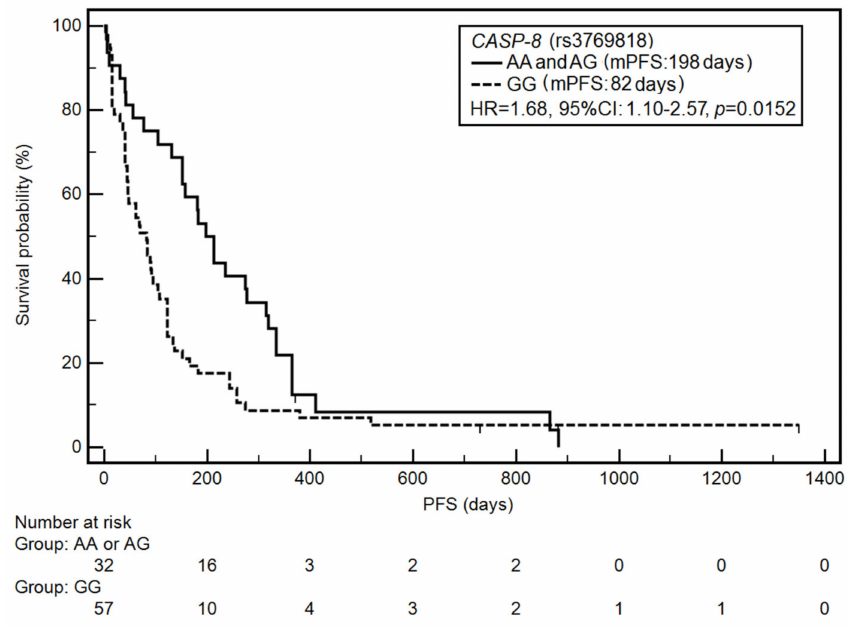
Figure 1. Kaplan–Meier curves illustrating progression-free survival (PFS) differences between genotypes AA and AG, GG of the CASP-8 gene (rs3769818). In contrast, the higher risk of TTP shortening was associated with a higher stage of disease (HR = 2.56, 95% CI: 1.67–3.92, p < 0.0001), a longer smoking period (HR = 1.54, 95% CI: 1.00–2.36, p = 0.0408), the use of cisplatin and pemetrexed in first-line chemotherapy (HR = 1.72, 95% CI: 0.97–3.03, p = 0.0240), a lower number of cycles (HR = 3.80, 95% CI: 1.90–7.59, p < 0.0001), the presence of distant metastases (HR = 2.36, 95% CI: 1.46–3.82, p = 0.0013), the GG genotype of the CASP-8 gene (HR = 1.70, 95% CI: 1.11–2.60, p = 0.0151) (Figure 2). The use of cisplatin and vinorelbine as the first line of treatment was associated with a significant reduction in the risk of TTP shortening (HR = 0.64, 95% CI: 0.40–1.02, p = 0.0380).